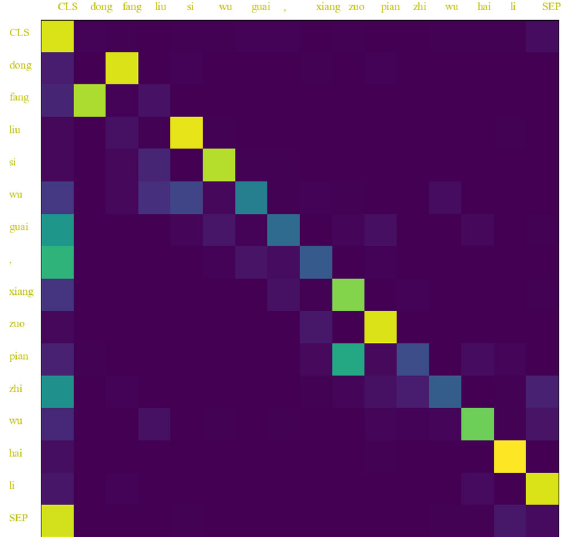
Figure 10. Heat map of attention results of Ernie-Gram module.